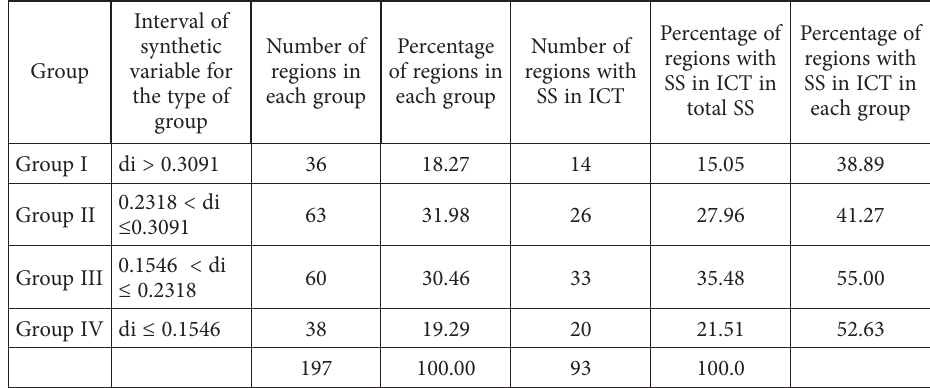
Interval of synthetic variable for the type